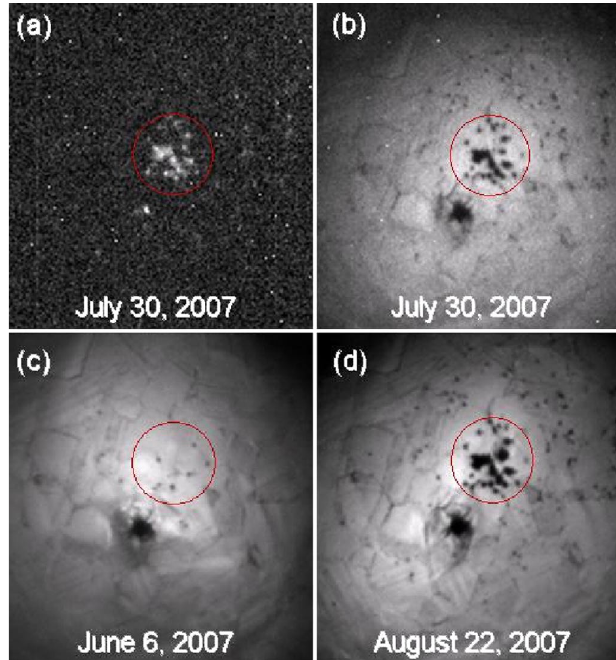
FIG. 16. (Color) White light images of the cathode taken using oblique illumination (a) and using normal-incidence illumination (b), both taken on July 30. Normal-incidence images taken on June 6 (c), early in the run, and again on August 22 (d), at the end of the run, clearly show the cathode image evolution. The camera views the cathode at normal incidence in all cases and the red circles show the nominal 1.3-mm diameter laser illumi- nation area.